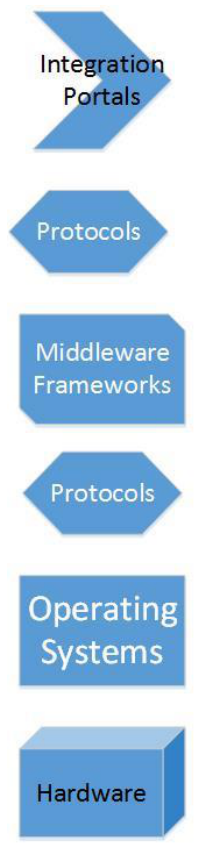
Figure 1.Components of an IoT